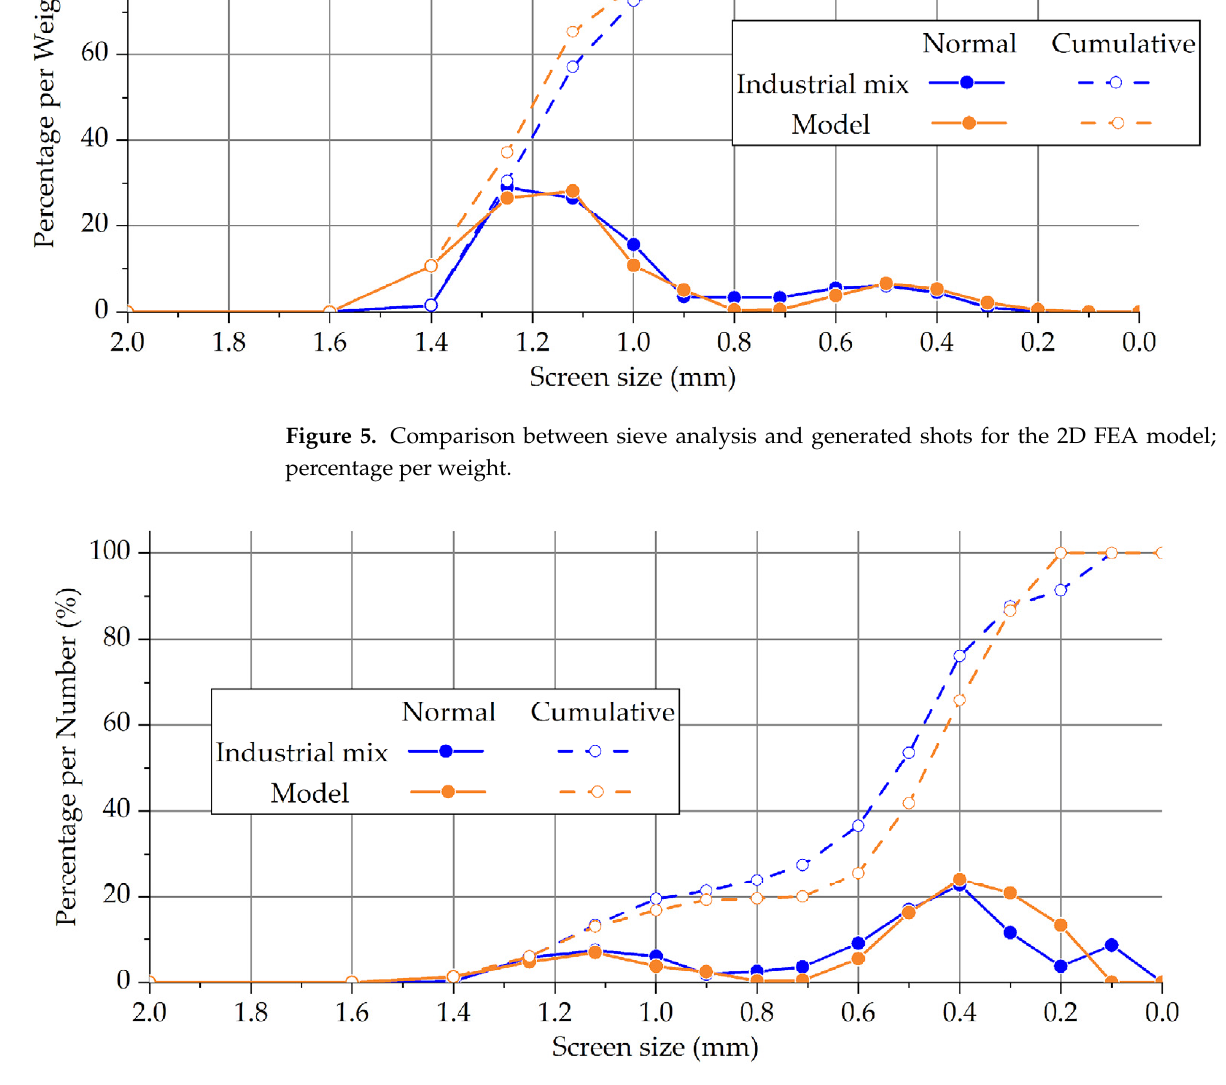
Figure 6. Normal and cumulative operational versus new S460 shot distributions per relative num- ber.